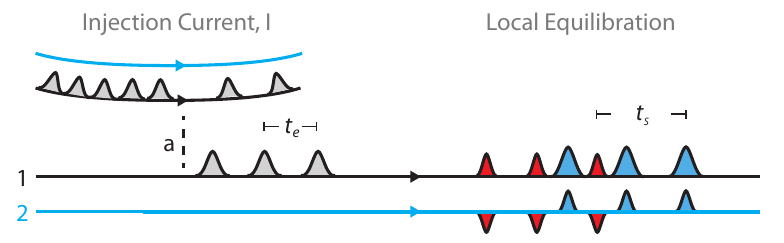
Figure 4: A random sequence of charge pulses is injected into edge mode 1, with an average time separation t between them. After the interaction quench, the generated charge and e > t neutral pulses mix among each other if t s e